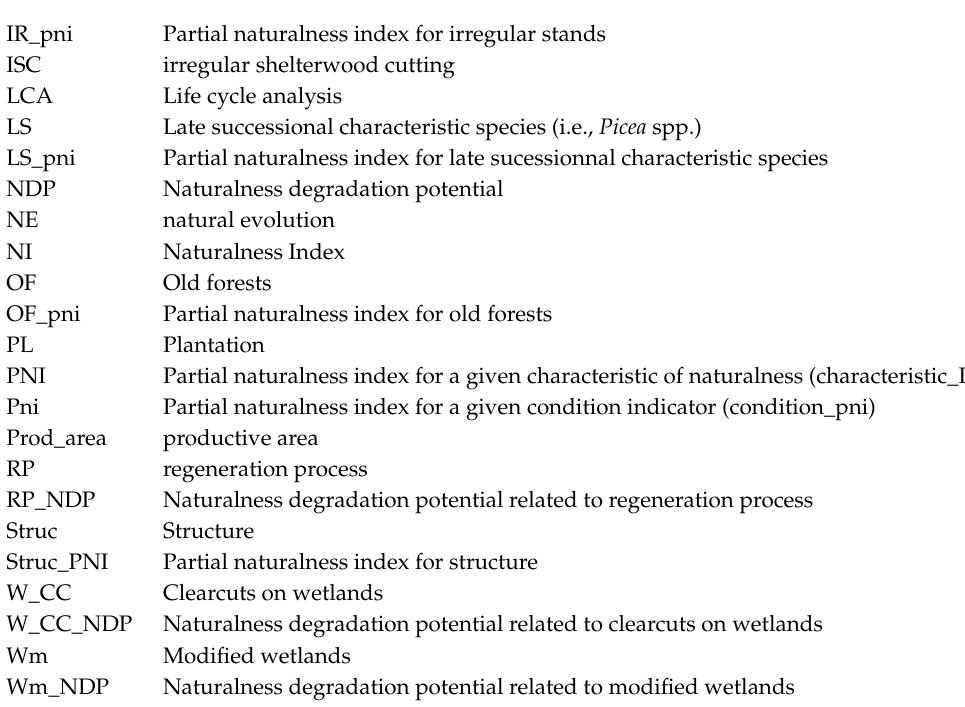
of each practice